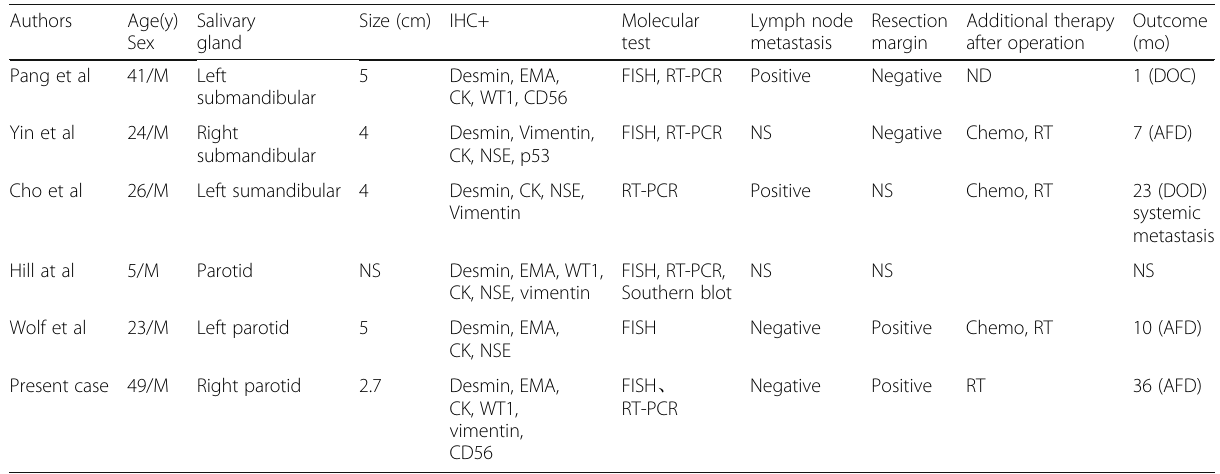
Table 2 Clinicopathological summary of Major Salivary Gland DSRCT